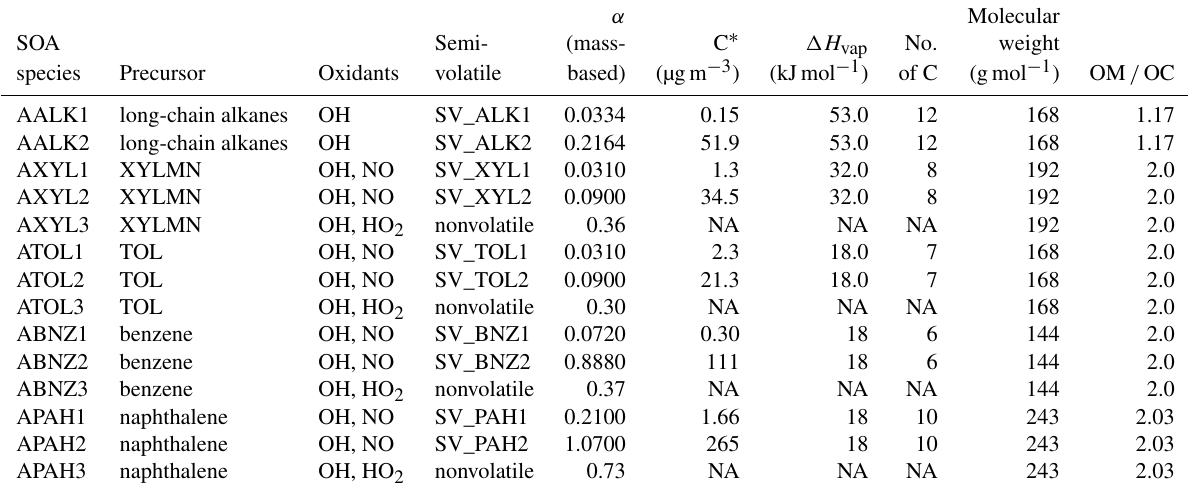
Table 8. Properties of anthropogenic traditional semivolatile SOA precursors in CMAQv5.2. NA denotes not